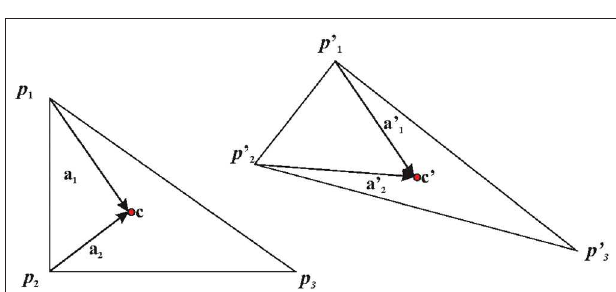
FIGURE 4 | Left panel : an undeformed triangle. Right panel : its deformed state. Axes used for deriving F are shown. c,